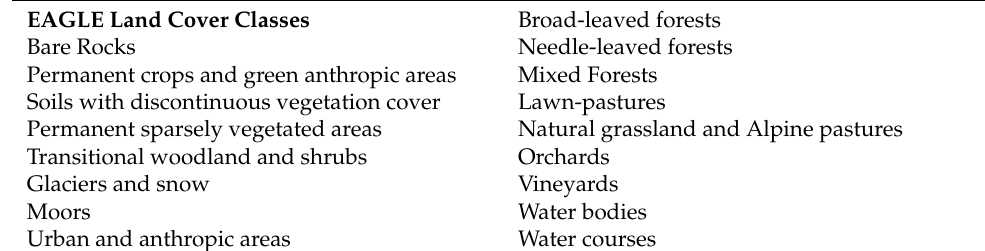
Table 7. Classes mapped.